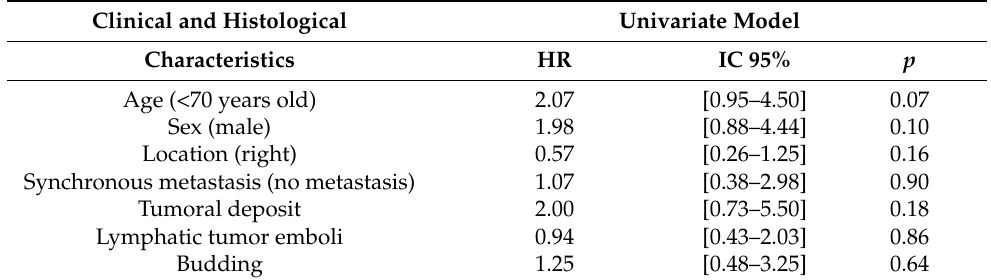
Table 3. Logistic regression model between histopronostic factors and RASSF2 methylation status.